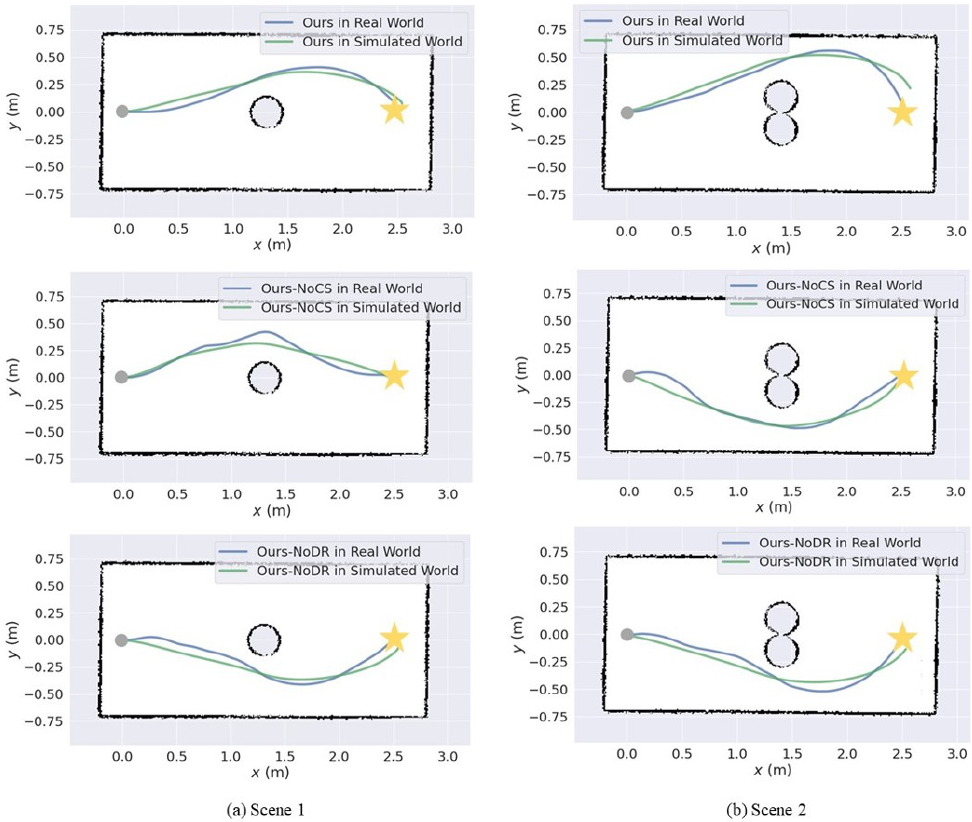
Figure 13. Trajectories generated by the different methods. The stars denote target positions, the gray dots denote starting points, the blue trajectories come from real experiments, and the green trajectories are from simulation experiments.